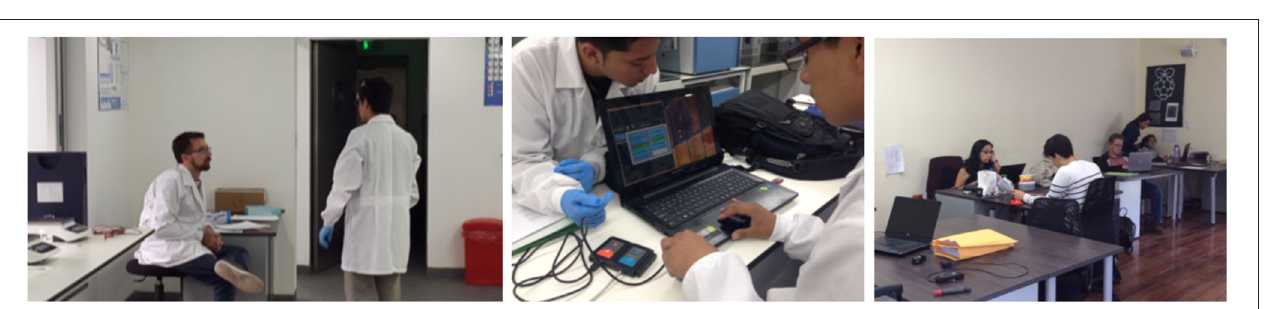
FIGURE 3 | Different types of interactions in academic spaces (offices, laboratories, and field